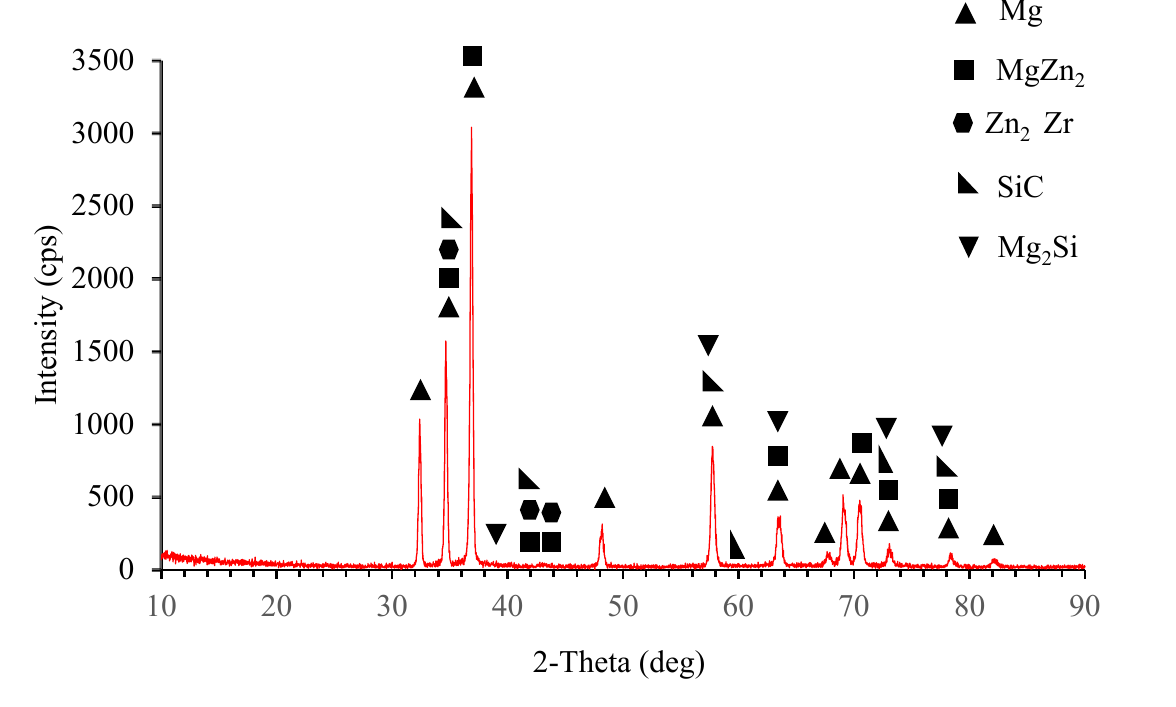
Figure 6. XRD patterns of the ZK60 SiC15 composite.